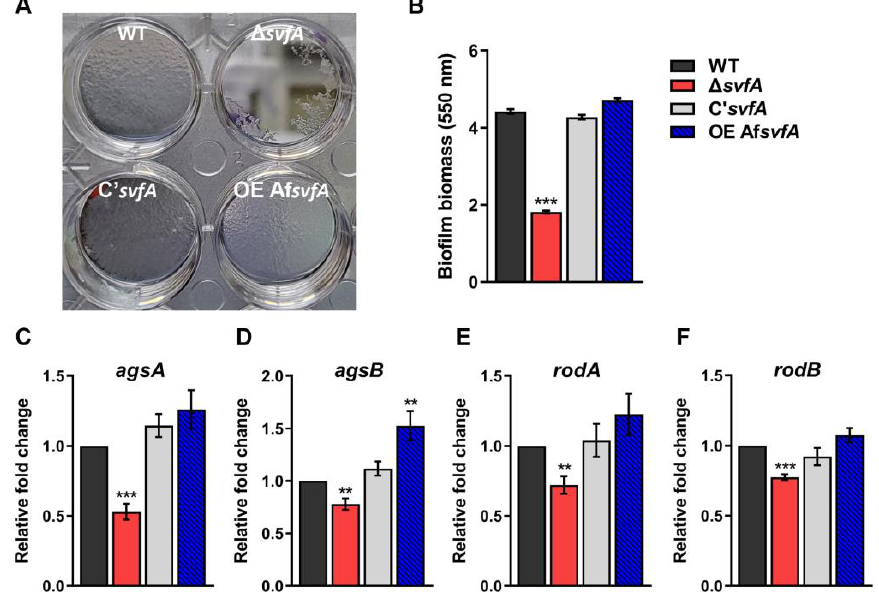
Figure 1. Role of SvfA in A. nidulans biofilm formation. Biofilm formation was evaluated after 16 h of growth in GMM. ( A ) Visualization of biofilms attached to the bottom of the individual wells in a 12-well plate. ( B ) Crystal violet staining assay. The biofilms were stained with 0.01% crystal violet and dissolved in 30% acetic acid solution. N = 12. ( C – F ). Relative expression of α -1,3-glucan synthase genes ( agsA and agsB ) and hydrophobin genes ( rodA and rodB ). Total RNA was extracted from biofilm cultures. RT-qPCR analysis was performed using 18S rRNA gene as an internal control. N = 10. ** p ˂ 0.01, *** p ˂ 0.001.